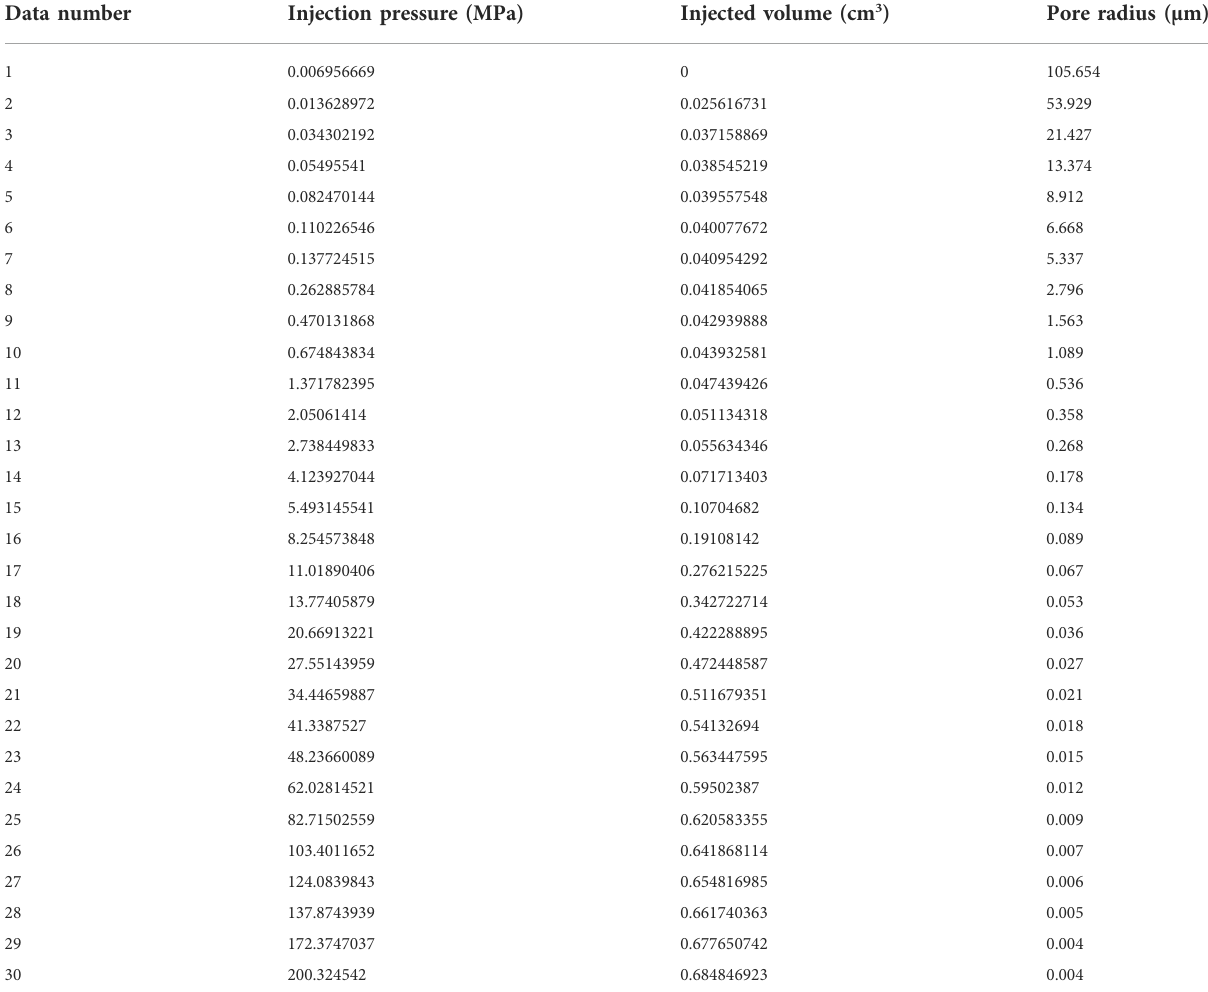
TABLE 1 Normalized pore size distribution obtained from mercury intrusion